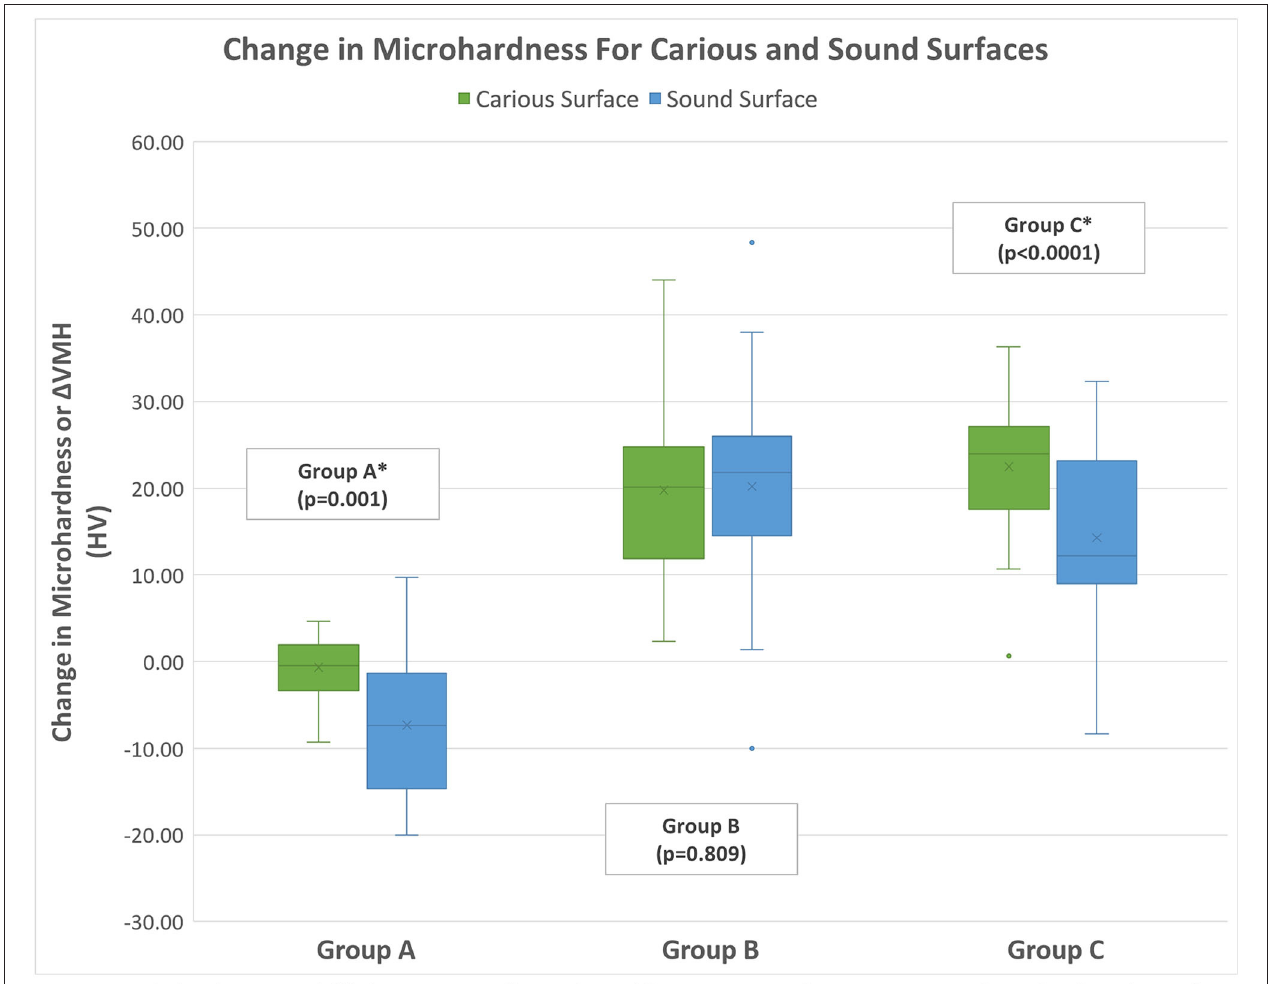
FIGURE 3 | Average change in microhardness ( 1 VMH) after SDF protocol.